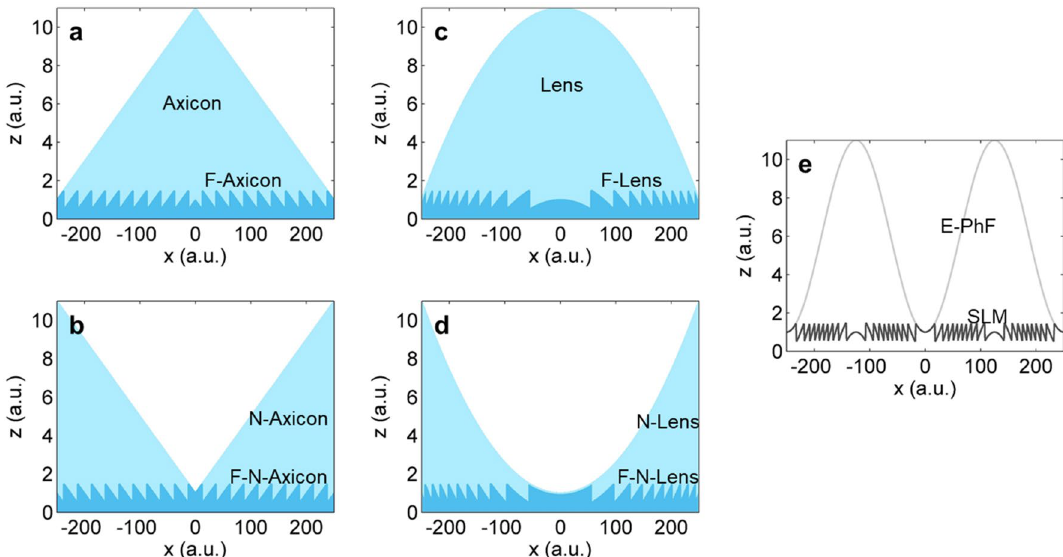
Figure 2. Fresnel optics and SLM. ( a ) Axicon and Fresnel axicon (F-Axicon); ( b ) negative axicon (N-Axicon) and Fresnel negative axicon (F-N-Axicon); ( c ) lens and Fresnel lens (F-Lens); ( d ) negative lens (N-Lens) and Fresnel negative lens (F-N-Lens); and ( e ) SLM’s phase modulation and its equivalent phase-front (E-PhF). SLM, spatial light modulator. Figure generated by Microsoft® Visio® 2013 50